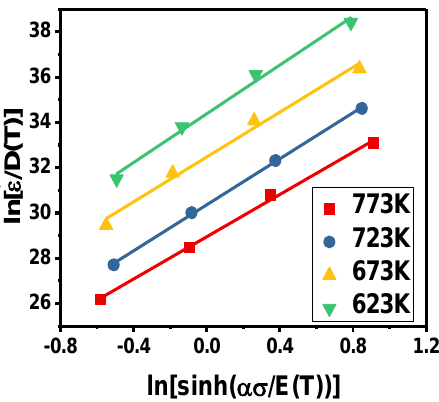
Figure 5. Relationship between ln[𝜀̇ 𝐷(𝑇)⁄ ] against ln{𝑠𝑖𝑛ℎ[𝛼𝜎 𝐸(𝑇)⁄ ]} for different parameters.